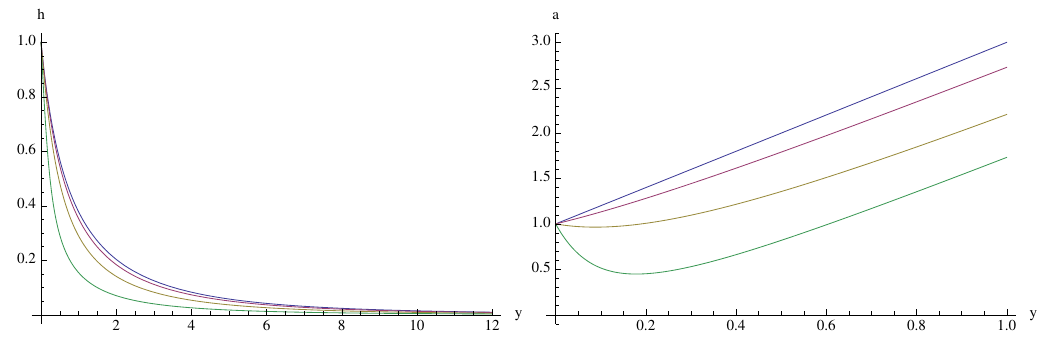
2 = 2 with (cid:22) = (cid:21) = 1 (cid:25) U U